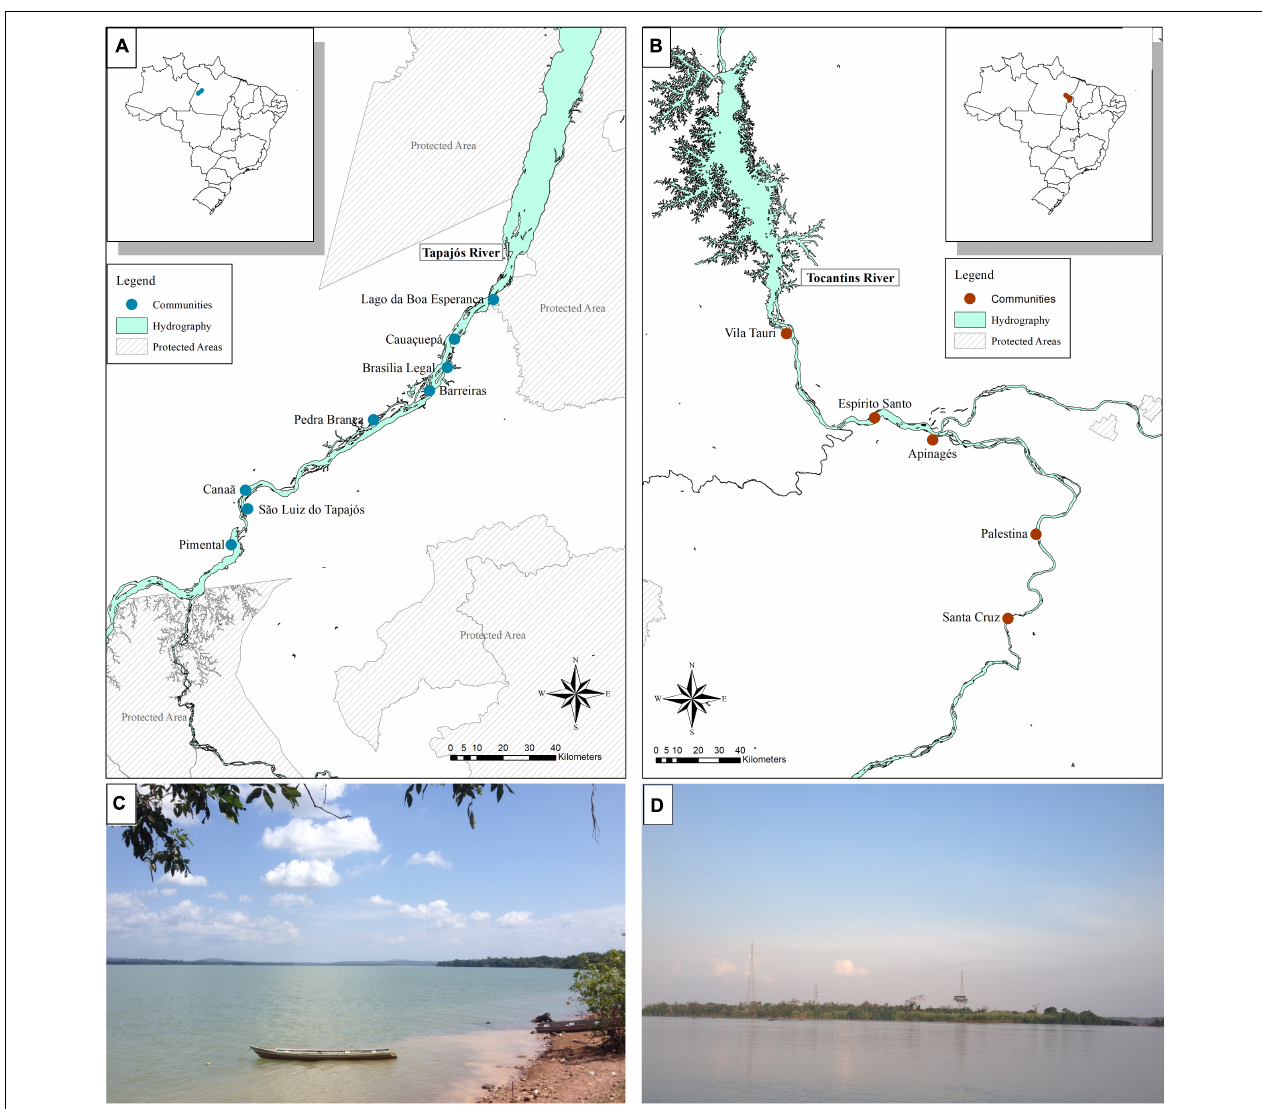
FIGURE 1 | Location of rivers, communities and sampling sites of interviews and fish samples for stable isotopes analysis in the Tapajós (A,C) and Tocantins (B,D) rivers, in the Brazilian